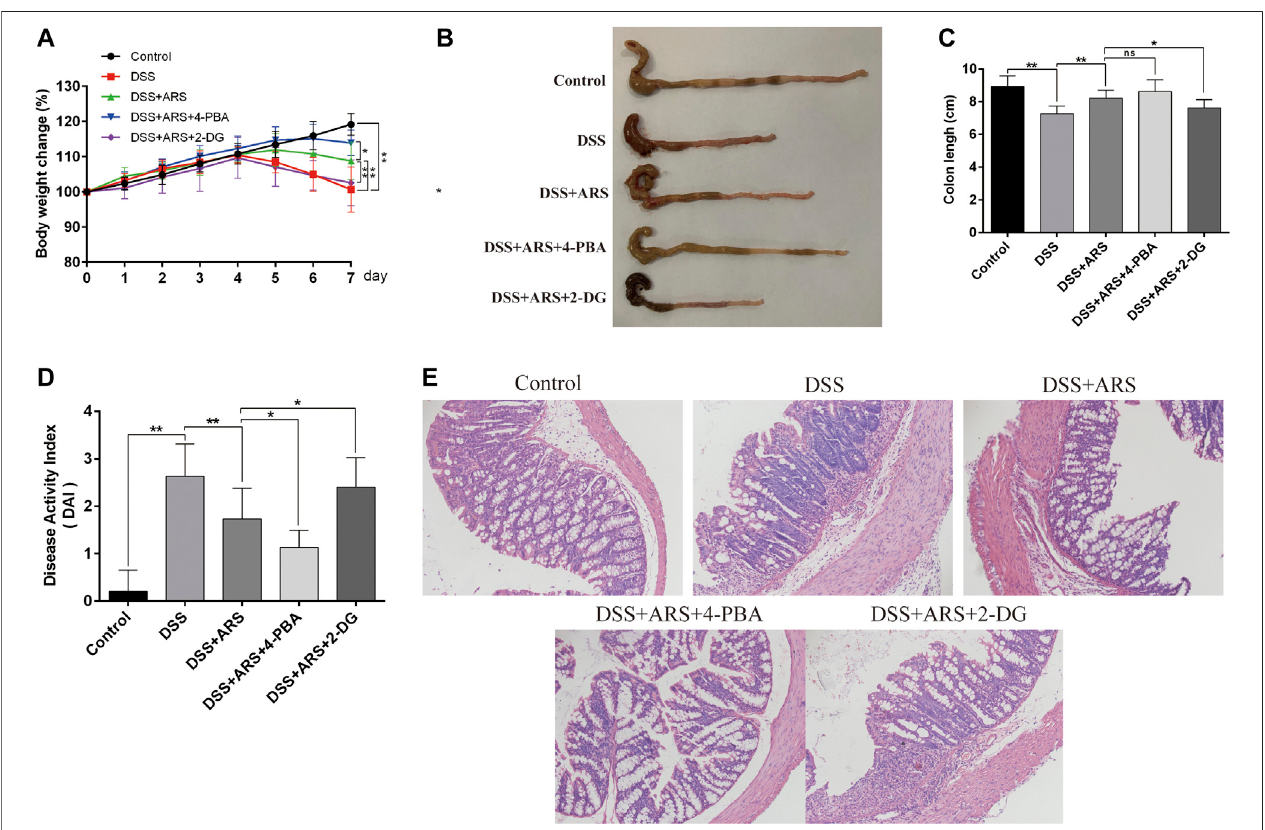
FIGURE5| ERstressinhibitioninvolvesinthetherapeuticeffectofARSonclinicalandhistologicalsymptomsinDSS-inducedcolitis.ERstressinhibitor4-PBAand inducer2-DGwereusedtoverifytheroleofERstressonthetherapeuticeffectofARS. (A) Thebodyweightchangeofmiceineachgroup. (B) Macroscopicappearances of colon in different groups. (C) The average colon length of mice in each group. (D) Disease activity index of colon, a composite measure of weight loss, stool, consistency and blood in stool. Data are presented as mean ± SD ( n (cid:1) 10). * p < 0.05 and ** p < 0.01. (E) The pathological evaluation of colonic tissues was performed using H.E. staining and observed under 200 × phase contrast